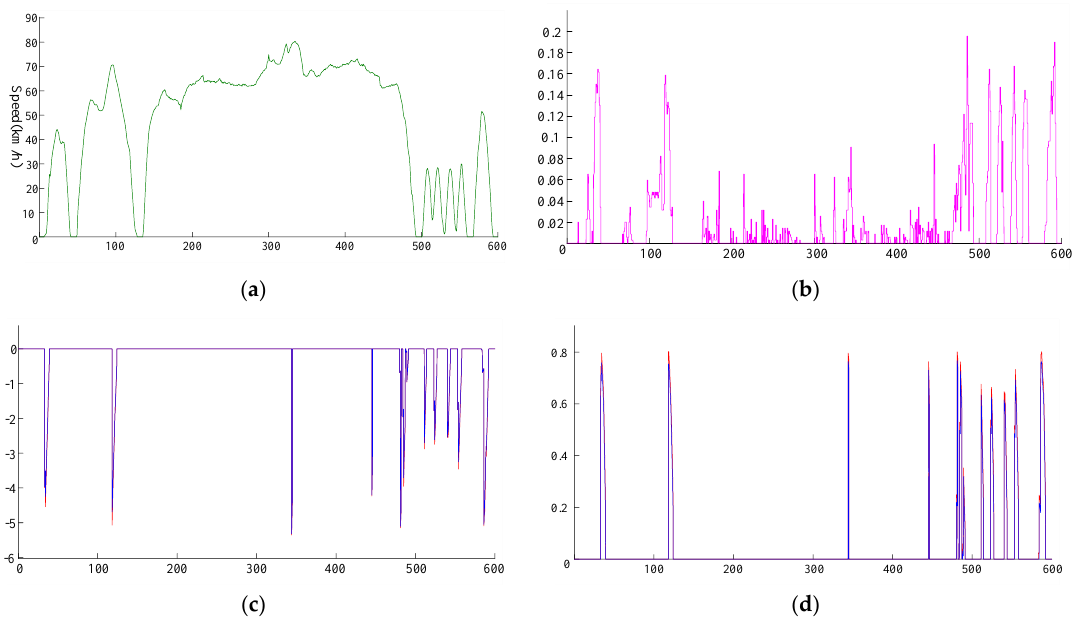
Figure 17. US06 simulation results. ( a ) Vehicle speed; ( b ) Braking strength; ( c ) Front motor power; ( d ) Front regenerative braking system efficiency.